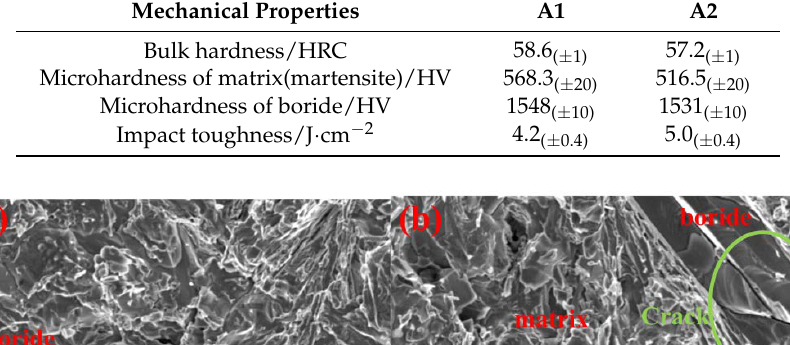
Table 4. Mechanical properties of the as-cast and heat-treated Fe-Cr-B alloys. Mechanical Properties